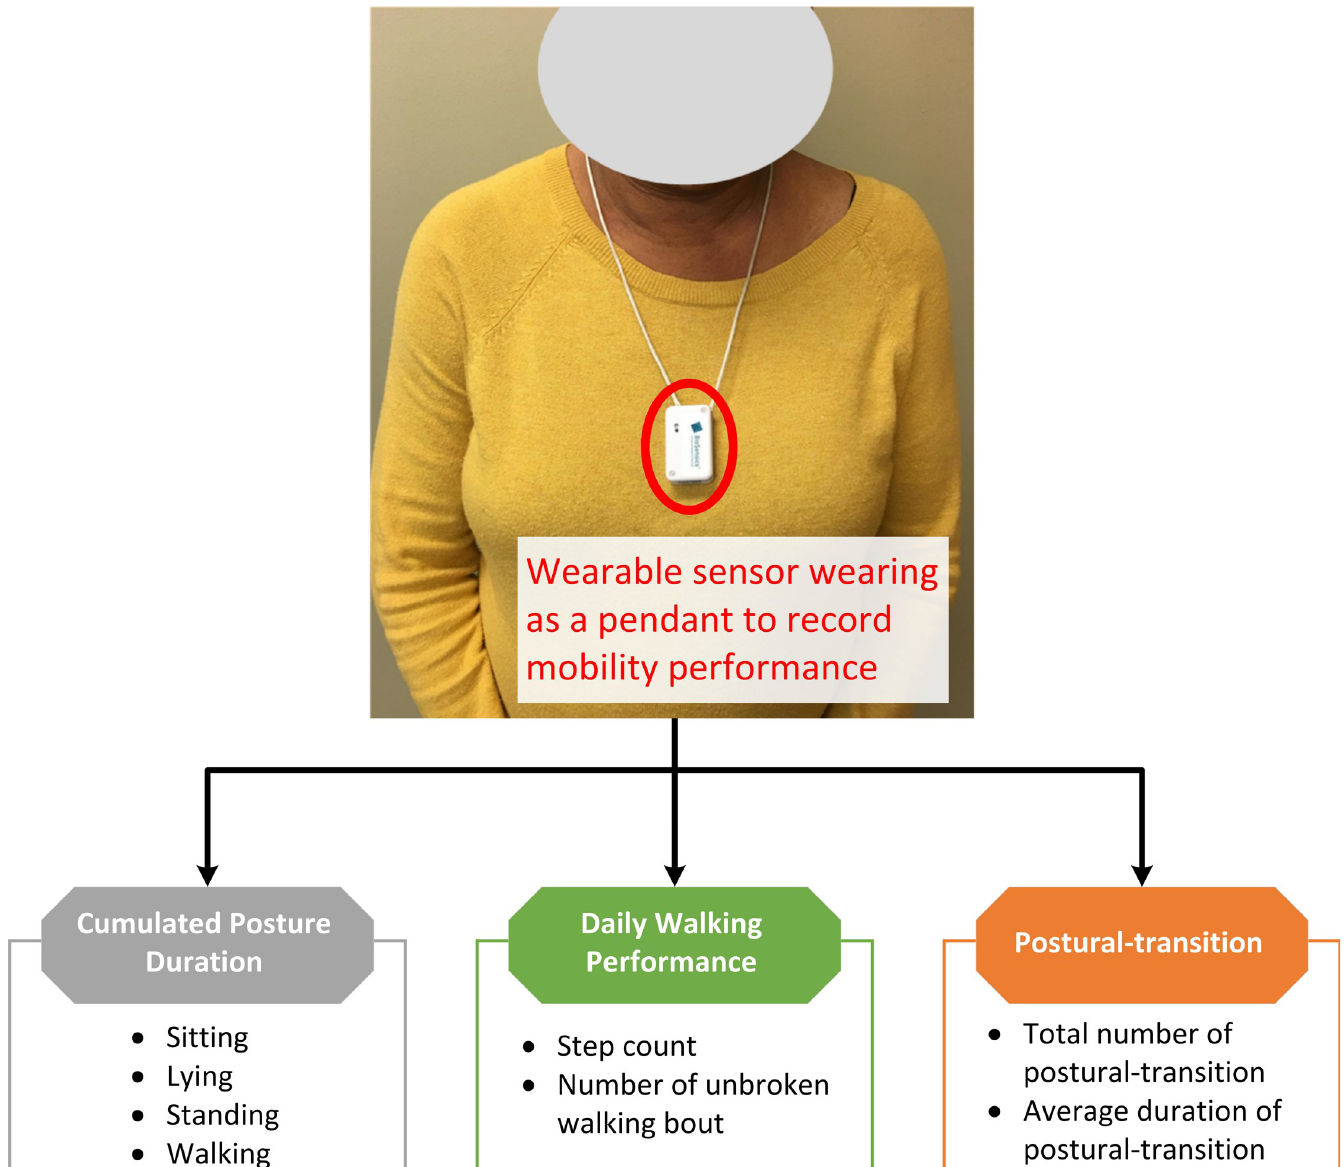
Fig 1. A patient wearing the sensor as a pendant. Detailed metrics of mobility performance, including cumulated posture duration (sitting, lying, standing, and walking), daily walking performance (step count and number of unbroken walking bout), as well as postural-transition (daily number and average duration), were